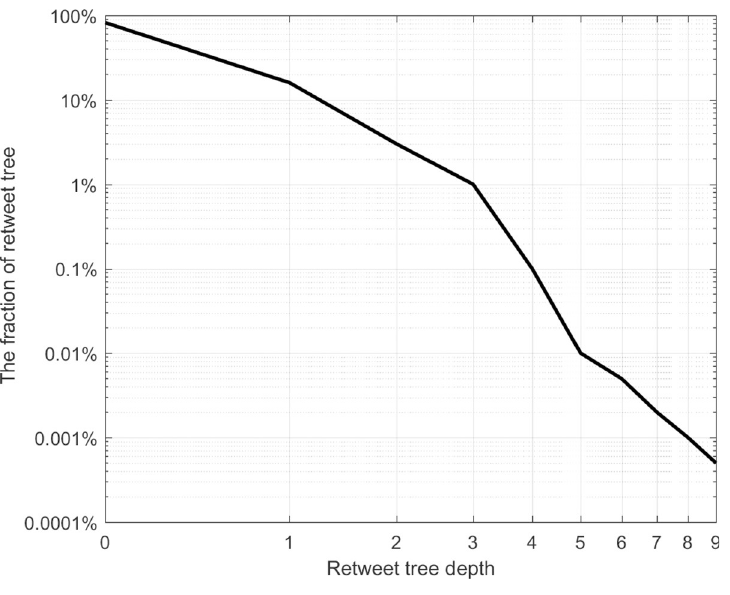
Fig 3. The fractions of retweet trees.